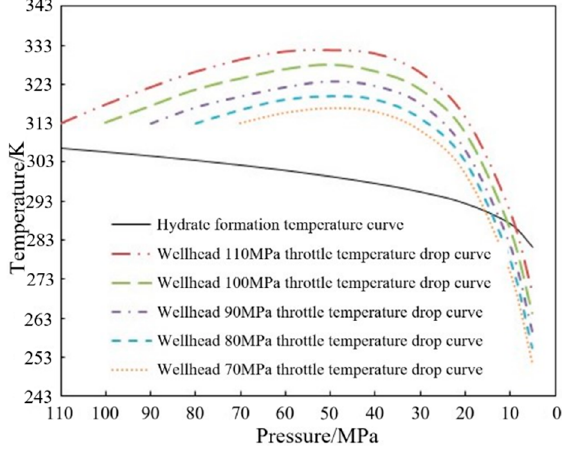
Figure 4. Throttle temperature drop curve and hydrate formation condition curve under different wellhead pressures.